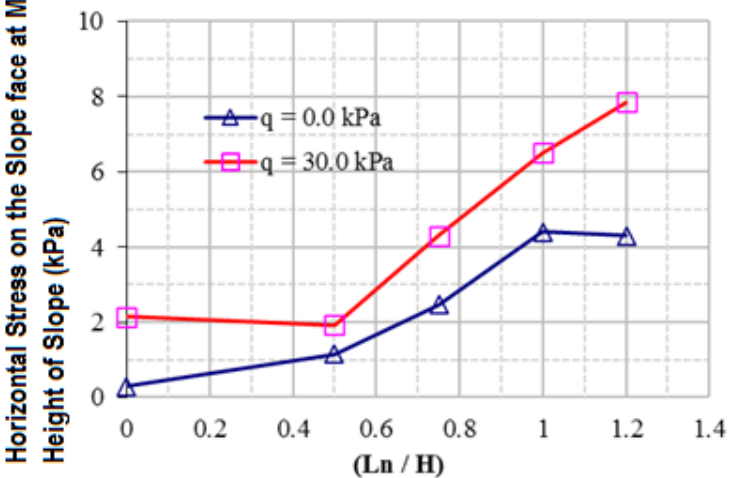
Figure 11. Influence of nail length on the slope face horizontal stresses at mid height of slope.